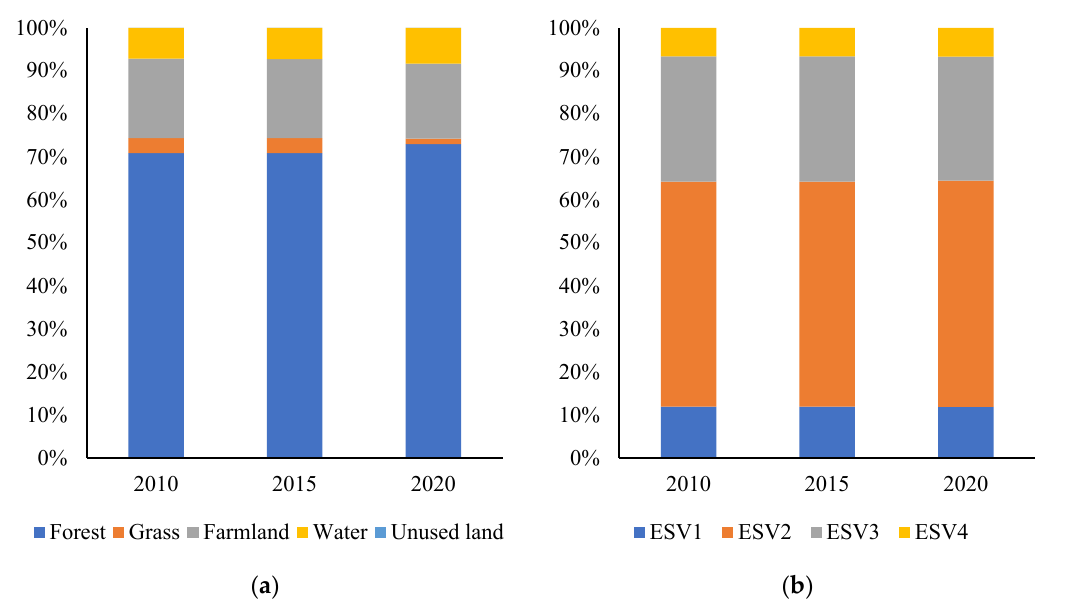
Figure 4. Proportions of ESV in the Dabie Mountain area in 2010, 2015, and 2020 according to ( a ) land cover types and ( b ) ecosystem service function types. ESV1: supply service, ESV2: regulation service, ESV3: support service, ESV4: cultural service.